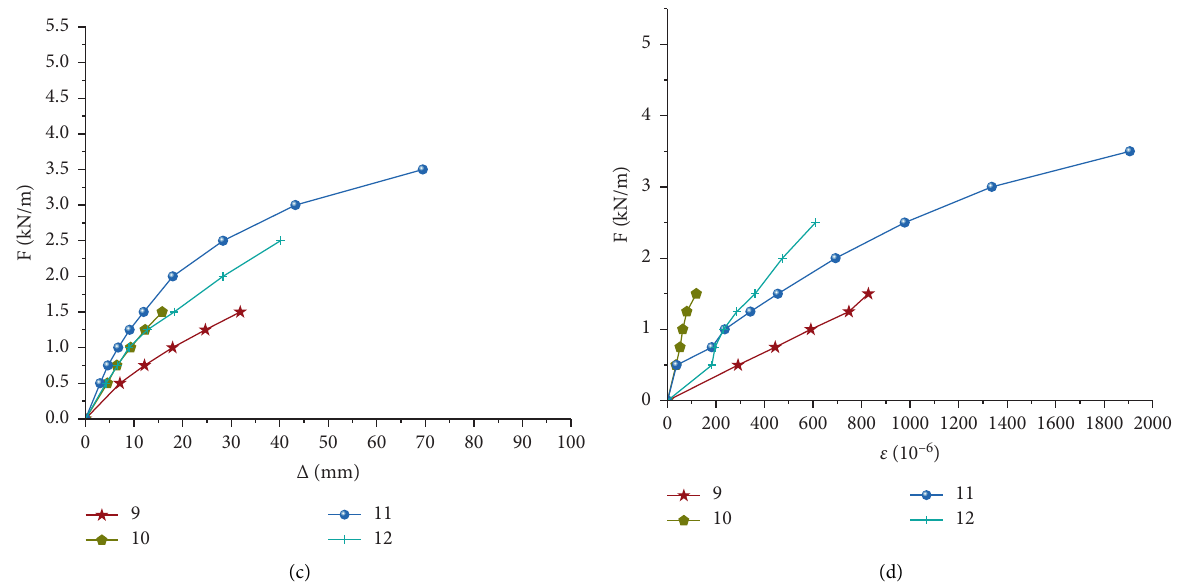
Figure 4: Load-displacement and load-strain test results of post components. (a) Load-displacement test results of steel pipe post components. (b) Load-strain test results of steel pipe post components. (c) Load-displacement test results of finished post components. (d) Load-strain test results of finished post components.